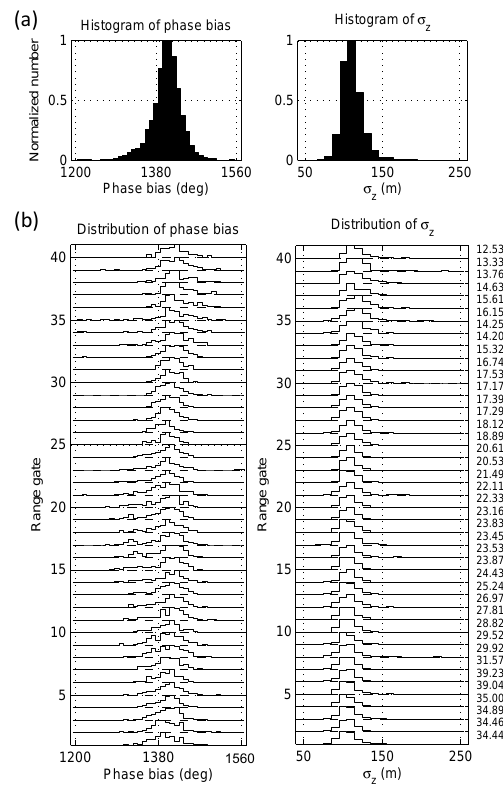
Figure 6: (a) Histograms of the calibrated parameters for the radar data shown in Fig. Figure 7. (a) Histograms of the calibrated parameters for the radar data shown in Fig. 4. (b) Normalized distributions of the calibrated 4. (b) Normalized distributions of the calibrated parameters at different range gates. parameters at different range gates. The value attached on the right The value attached at right side of each gate is mean SNR in dB of that gate. side of each gate is mean SNR in dB of that